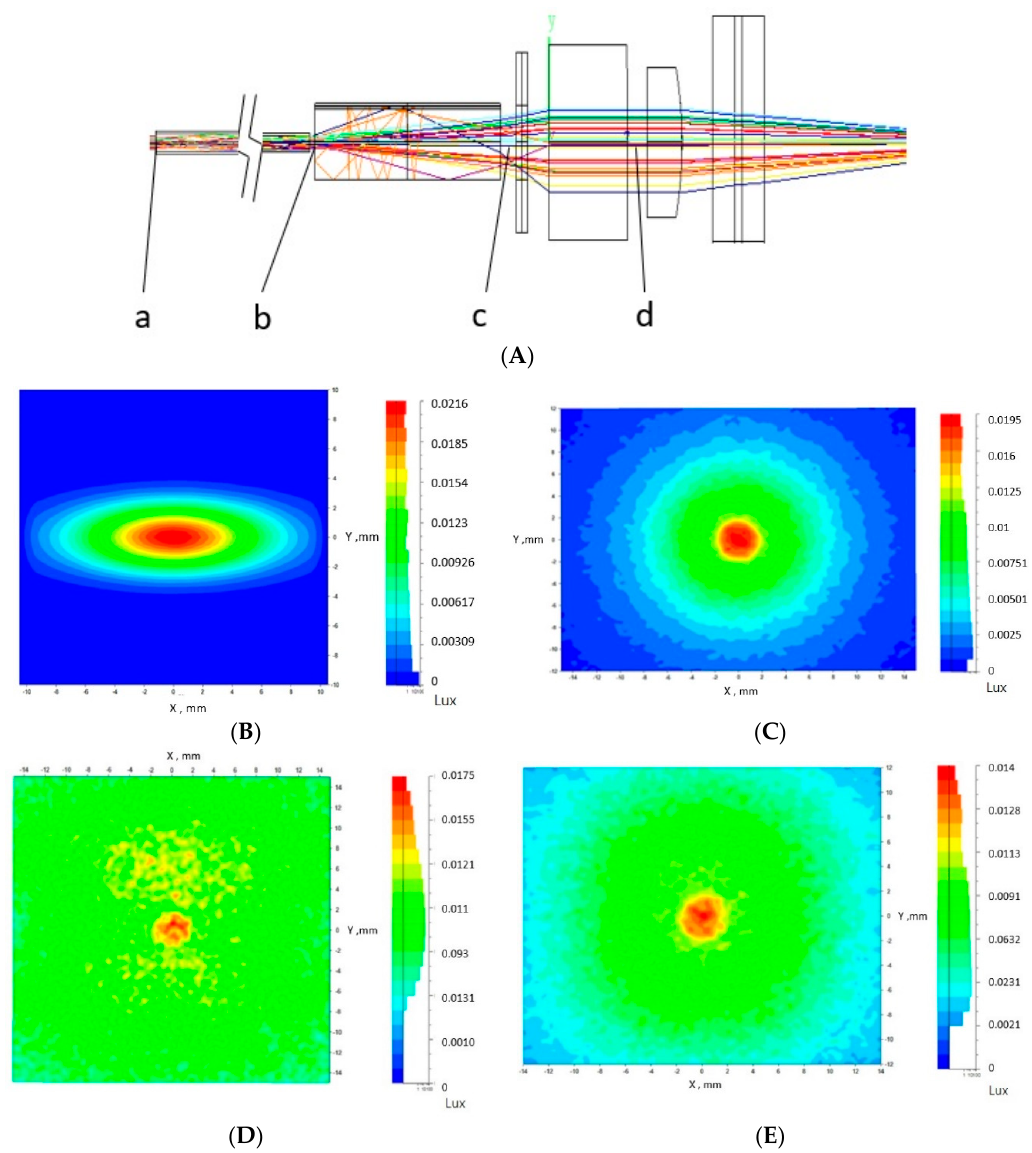
Figure 7. ( A ) Ray trace analysis of the optical system. Each chart indicates the different light source distribution at various image planes, ( B ) The output light pattern of laser beam , ( C ) the selected output light pattern from various optical fibers. If laser diode is selected, fiber must match this laser diode to reach maximum light efficiency, ( D ) The output light of ROD , ( E ) the optimized output light pattern of GRIN lens (also check Figure 2a,b).